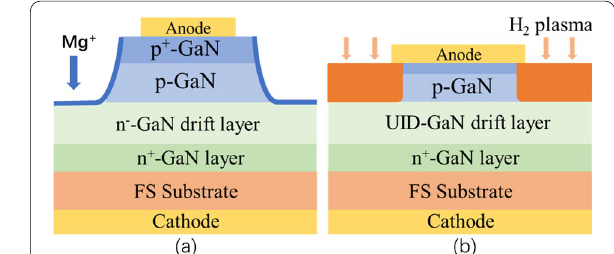
Fig. 8 a Schematic view of PND structure by Mg ion treatment; b PNDs with